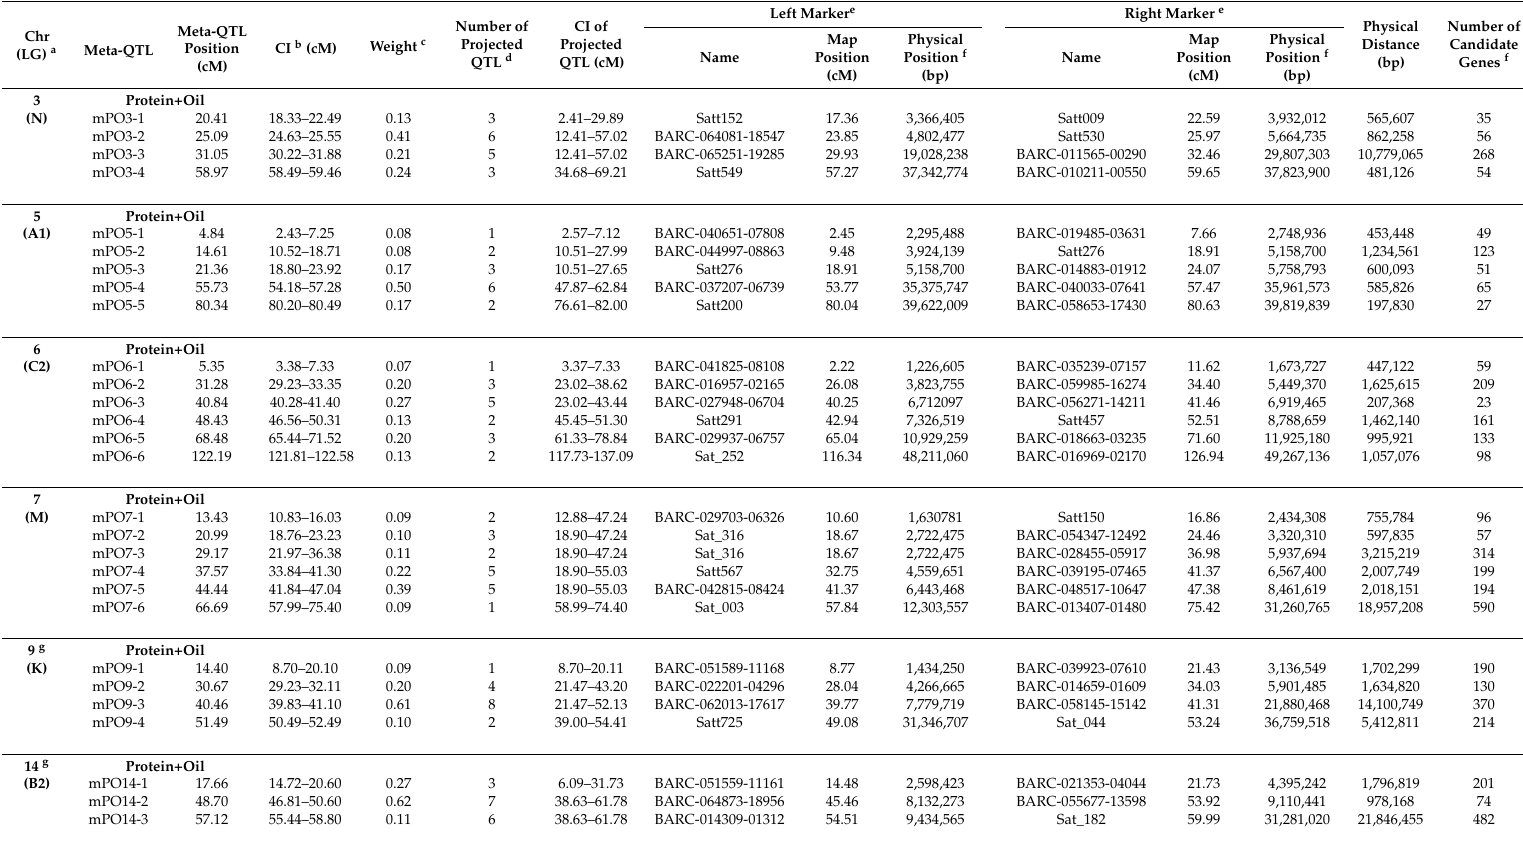
Table 1. Meta-Analysis results of quantitative trait loci (QTL) clusters of trait by